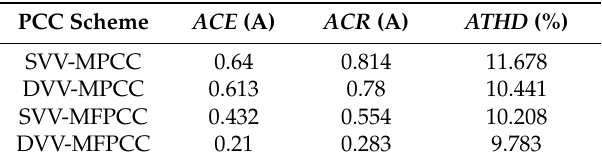
Table 10. ACE , ACR , and ATHD of the four schemes obtained from Figures 24–27.